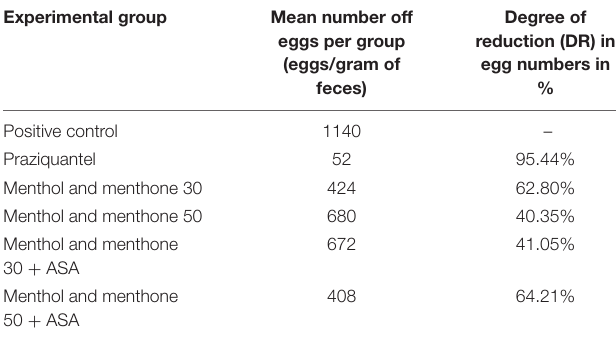
TABLE 2 | Mean number of eggs/gram of faeces and degree of reduction on egg numbers, after treatment (49 days post parasite infection). Experimental group Mean number off